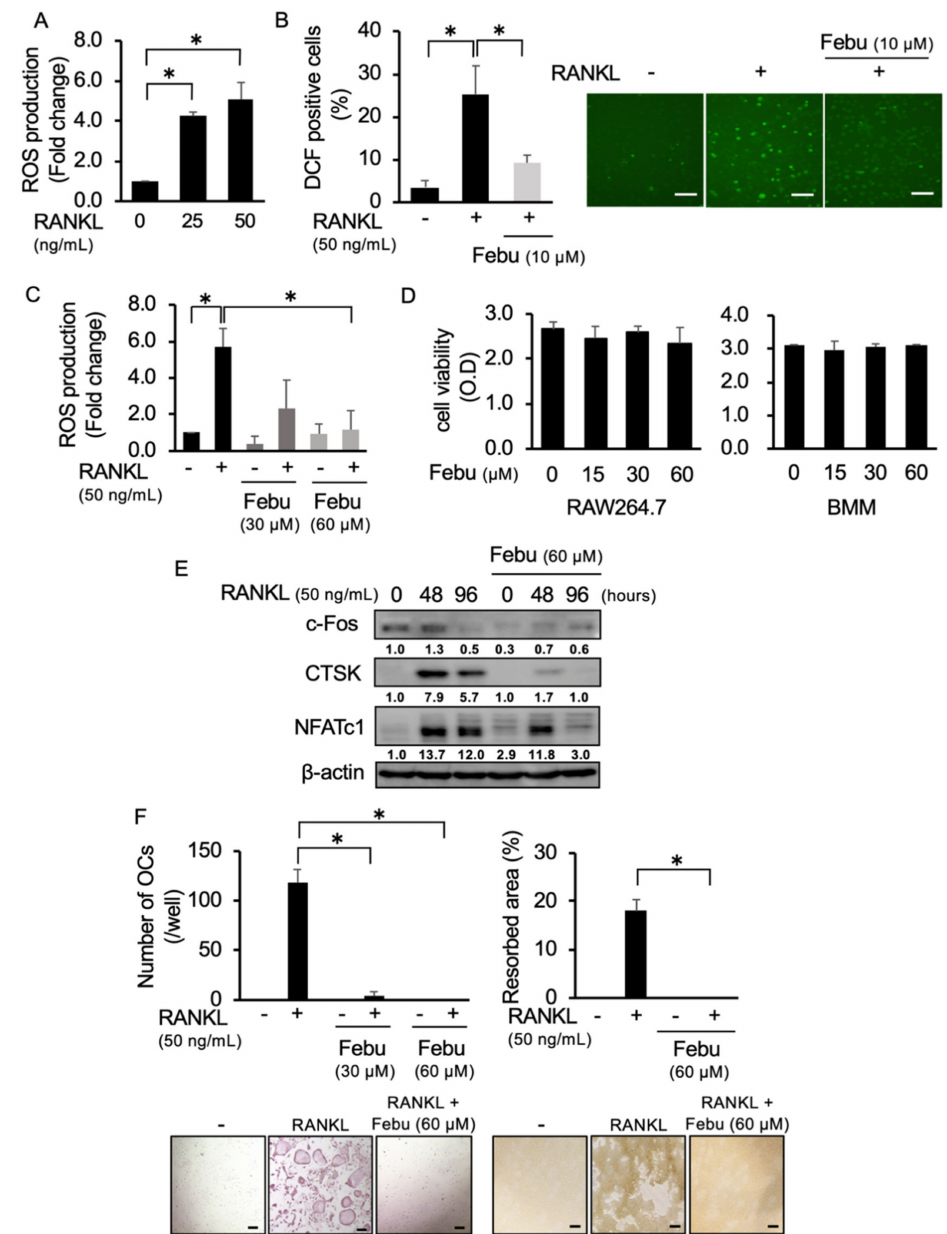
Figure 1. Febuxostat (Febu) inhibits receptor activator of NF- κ B ligand (RANKL)-induced reactive oxygen species (ROS) production and osteoclast (OC) formation. ( A ) RAW264.7 cells were seeded onto a glass-bottom 96-well plate and cultured in quadruplicate with indicated concentrations of RANKL for 30 min followed by staining with the ROS detector CellRox green. Data are expressed as fold changes from controls (mean ± SD). ( B ) RAW264.7 cells were seeded onto a glass-bottom 96-well plate and cultured with RANKL (50 ng / mL) with or without Febu at 10 µ M for 30 min.The number of RAW264.7 cells per field was counted under bright-field using a fluorescence microscope (BZ-X800) and ROS-expressing cells were defined as fluorescence DCF-positive cells (green). Data are expressed as % distribution of ROS-expressing cells (per field), mean ± SD. Representative photos are shown. Original magnification, × 200. Bar, 100 µ m. ( C ) RAW264.7 cells were seeded onto a glass-bottom 96-well plate and cultured in triplicate with RANKL (50 ng / mL) with or without the indicated concentrations of Febu for 30 min, followed by CellRox green staining. Data are expressed as fold changes from controls (mean ± SD). ( D ) RAW264.7 cells and bone marrow monocyte–macrophage lineage cells (BMMs)